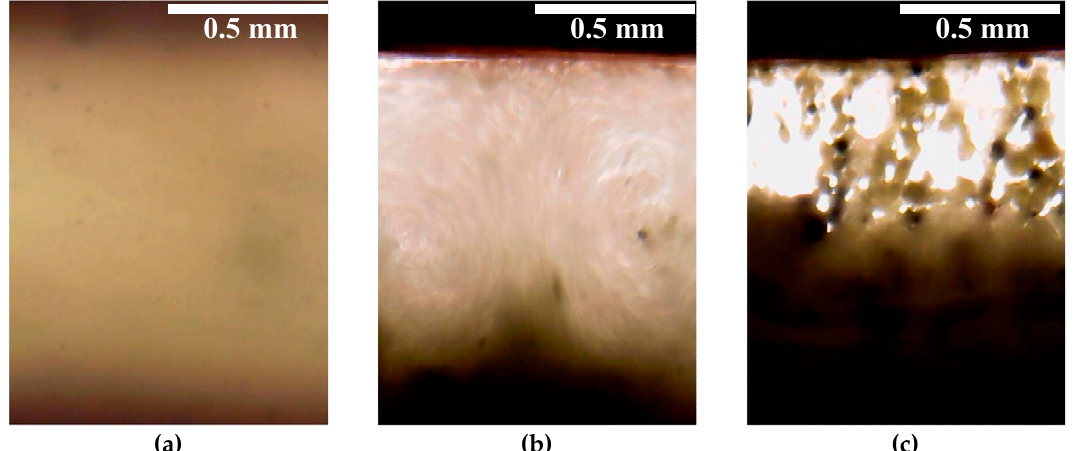
Figure 7. Experimental visualization of structure formation in electrorheological fluids containing 60 wt% WO 3 / DDA, using optical microscopy. Suspensions appeared ( a ) in the absence of an electric field, ( b ) in a 1 kV / mm electric field, and ( c ) in a 1.5 kV / mm electric field. In the microphotographs, the positive electrode is at the top.